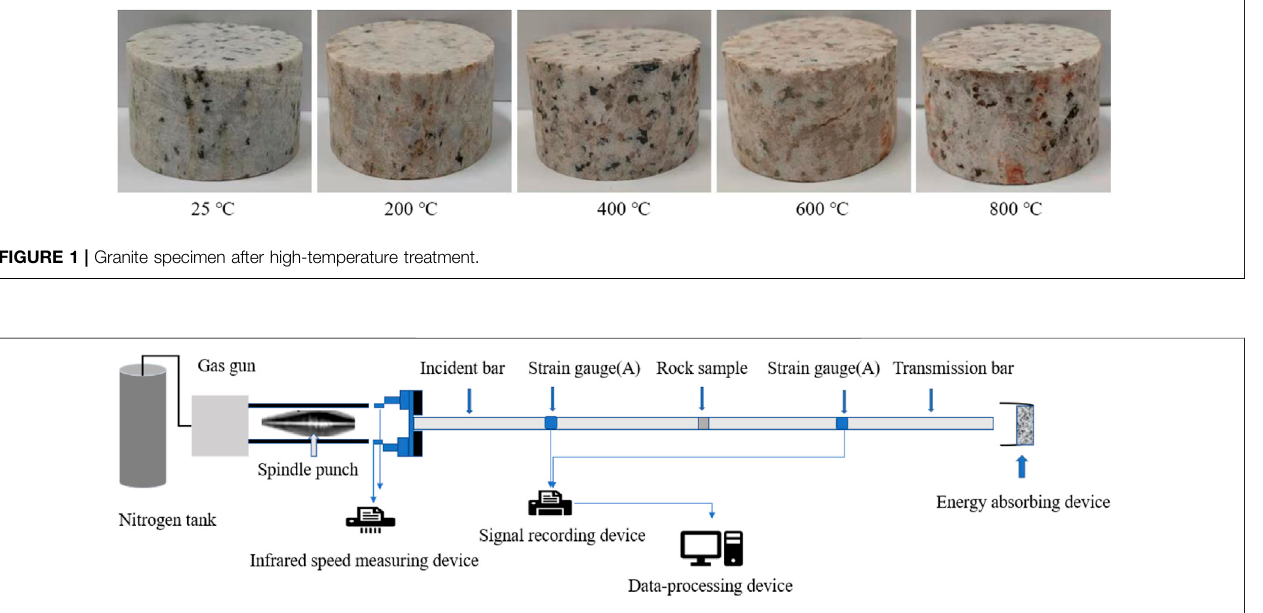
FIGURE 2 | Schematic of the split Hopkinson pressure bar